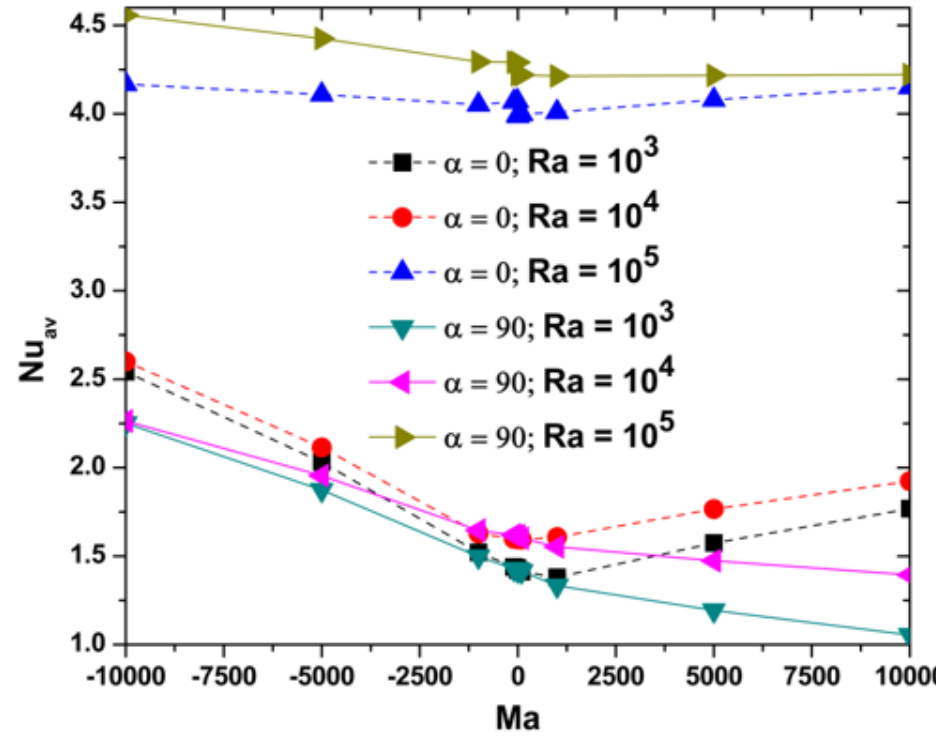
Figure 8. Marangoni number effect on average Nusselt number for different Ra, Ha = 40 and ϕ = 0.02. α = 0° (dashed lines) and α = 90° (solid lines).